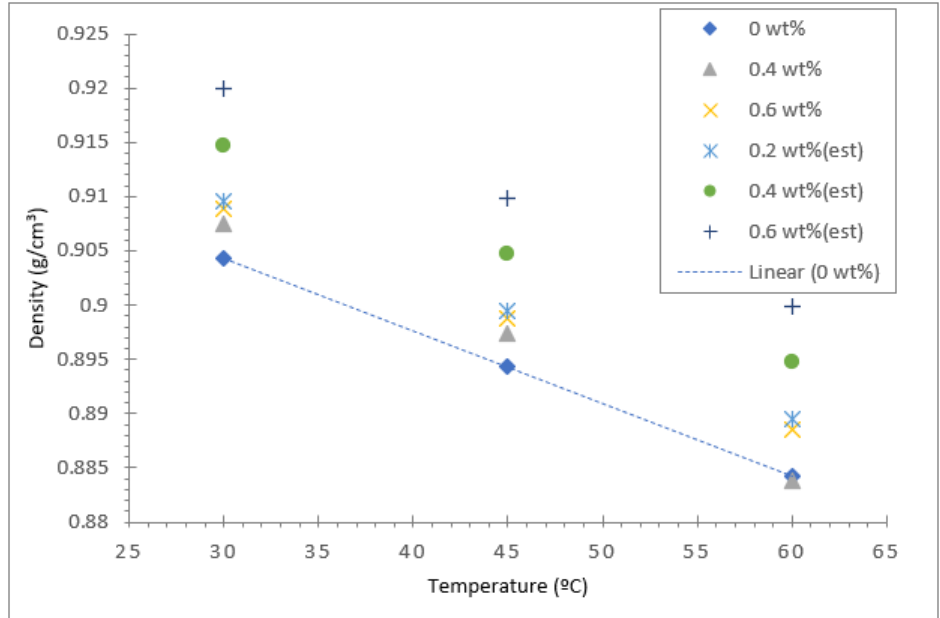
Figure 17. This Density of palm oil/Al 2 O 3 -TiO 2 hybrid Figure 17. This . Density of palm oil/Al 2 O 3 -TiO 2 hybrid nanofluid.